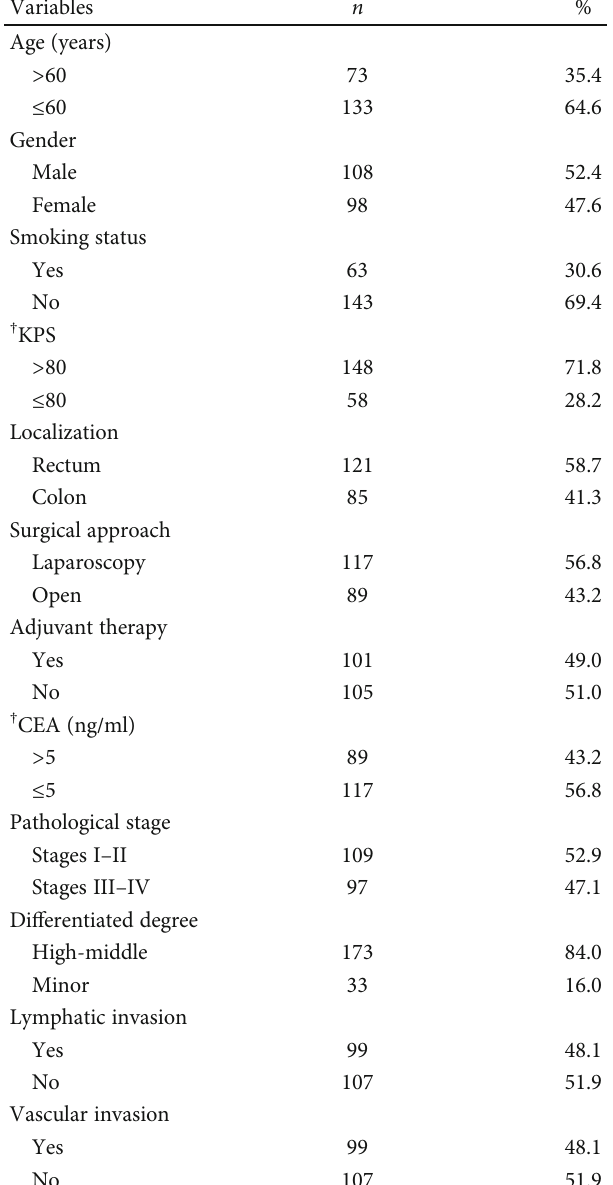
Table 1: Baseline